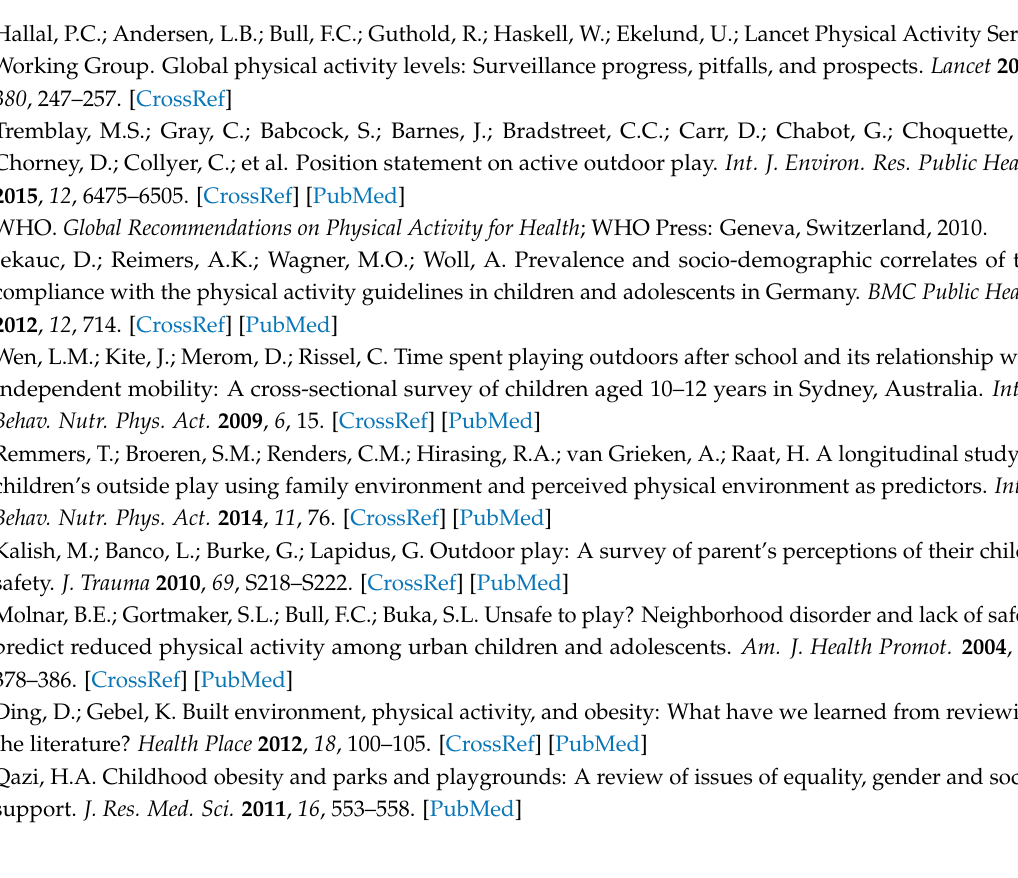
s1. Table S1: Information on user characteristics of the